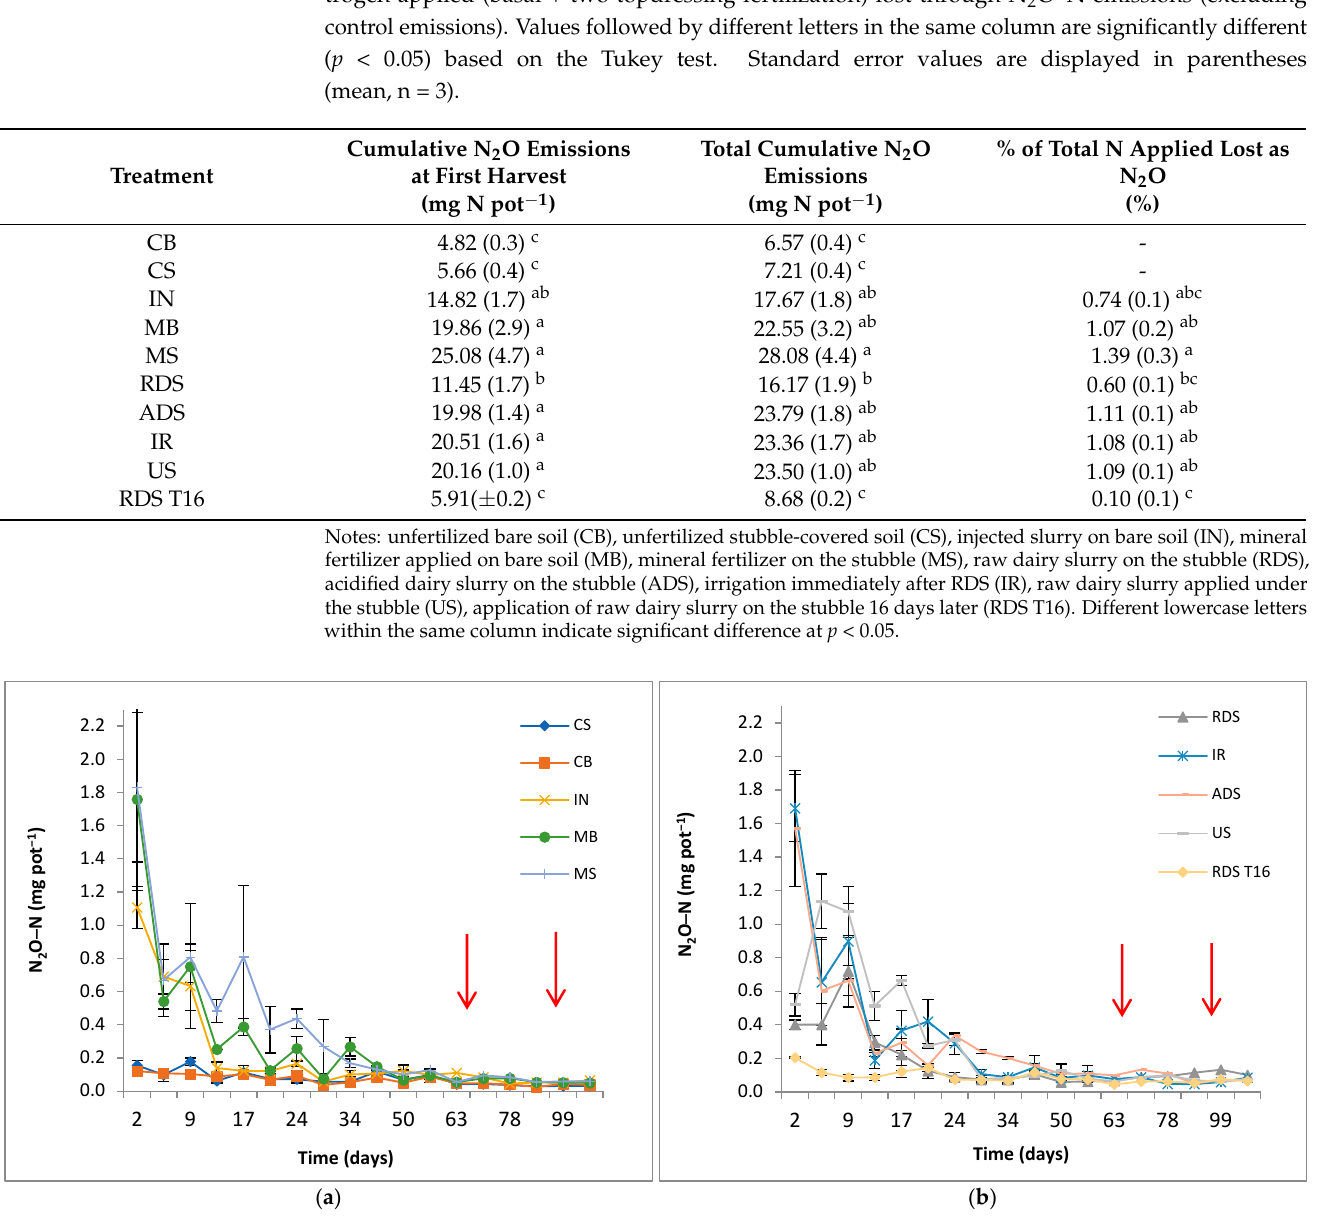
Figure 3. N 2 O–N daily fluxes (mg N 2 O–N pot –1 ). ( a ) Daily fluxes from CS, CB, IN, MB and MS. ( b ) Daily fluxes from RDS, IR, ADS, US and RDS T16. Arrows indicate the topdressing applications. Vertical bars represent the standard error of the mean (mean, n = 3). Unfertilized bare soil (CB), unfertilized stubble-covered soil (CS), injected slurry on bare soil (IN), mineral fertilizer applied on bare soil (MB), mineral fertilizer on the stubble (MS), raw dairy slurry on the stubble (RDS), acidified dairy slurry on the stubble (ADS), irrigation immediately after RDS (IR), raw dairy slurry applied under the stubble (US), application of raw dairy slurry on the stubble 16 days later (RDS